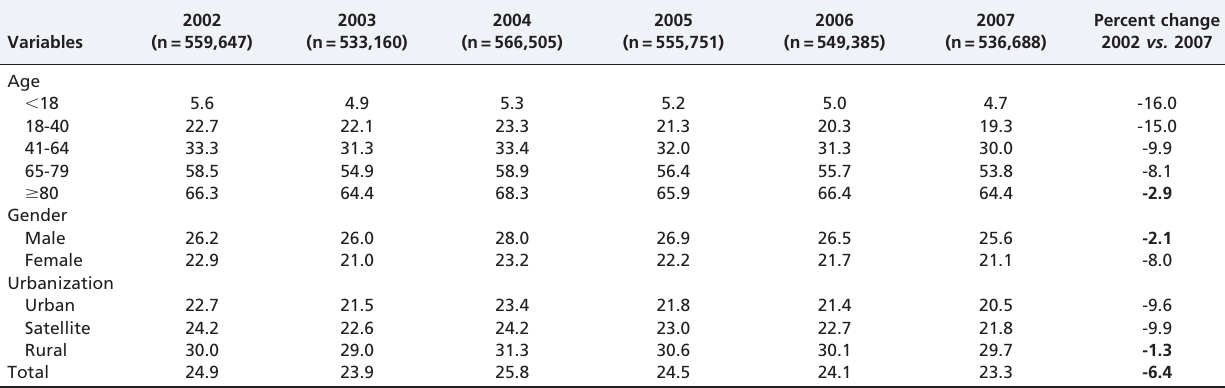
Table 2 - Prevalence rate of pethidine users,